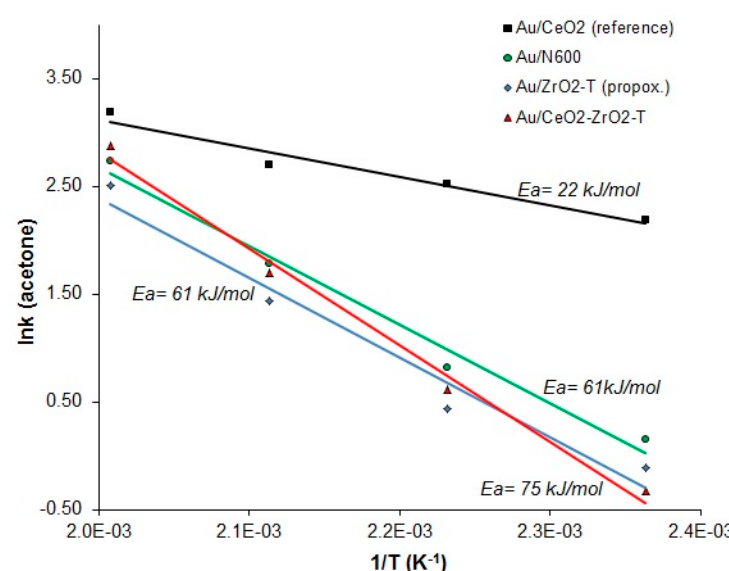
Figure 14. Arrhenius plots of the reaction rates of acetone vs 1/T for the 2-propanol decomposition reaction of various gold supported catalysts.